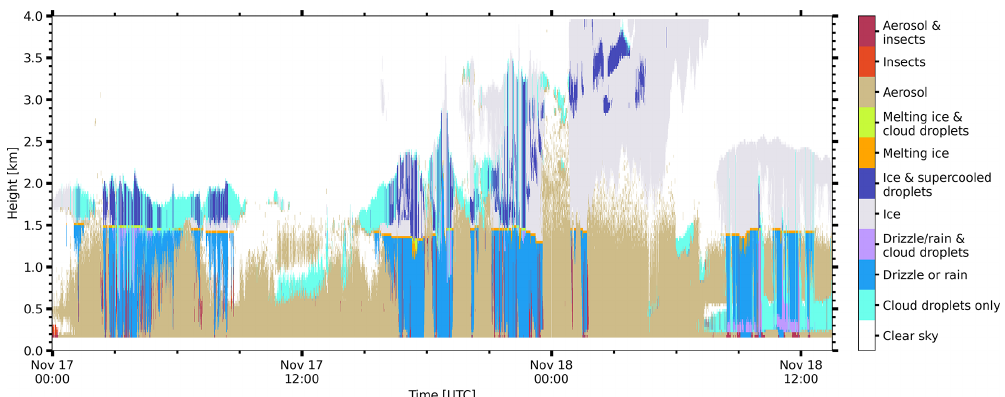
Figure A1. Zoom of Cloudnet target classification from 0 to 4km altitude for the 17–18 November 2014 case study in Cabauw, Netherlands.